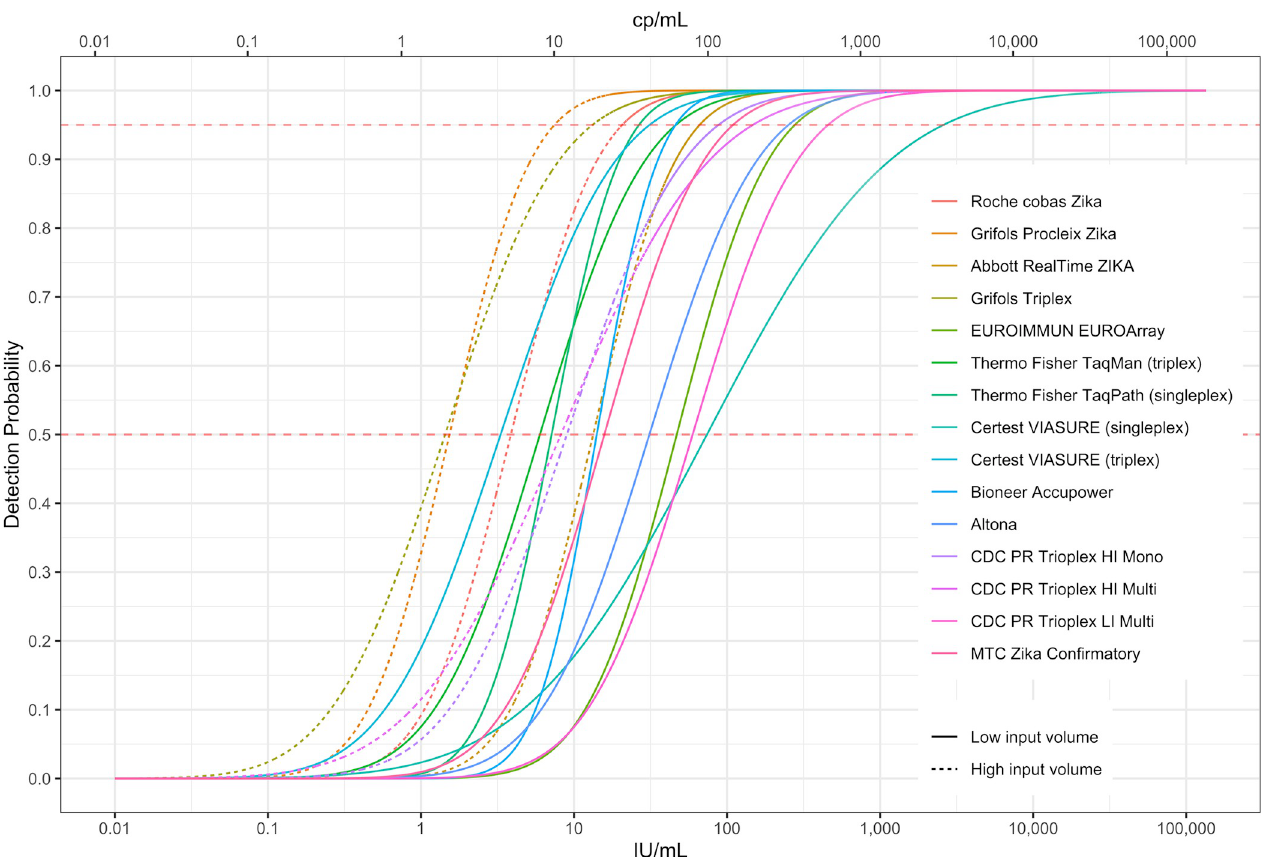
Fig 1. Analytic performance of plasma blood screening and diagnostic assays. Probit curves comparing analytical sensitivity of assays evaluated in this study by replicate testing of Polynesia isolate blinded panels, grouped by assay category or laboratories. The fitted probit regression model curve (solid lines) and standard errors were used to estimate LOD 50 and LOD 95 and confidence intervals presented in Table 2.